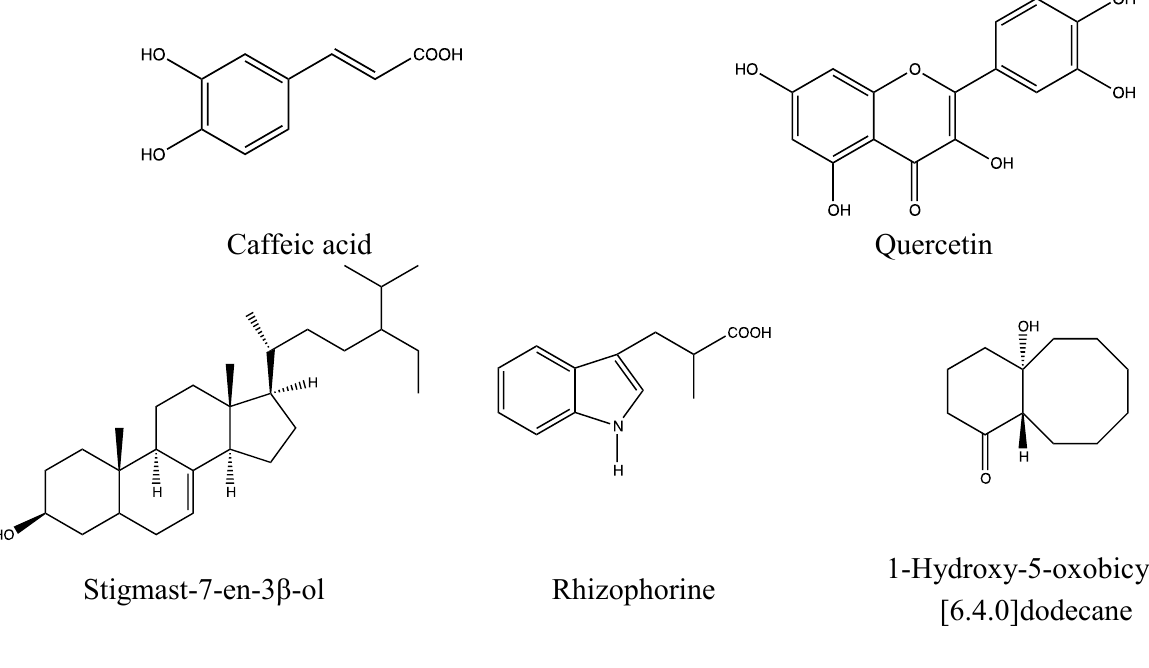
Figure 10. Constituents of Rhizophora mucronata bark (above) and leaves (below).